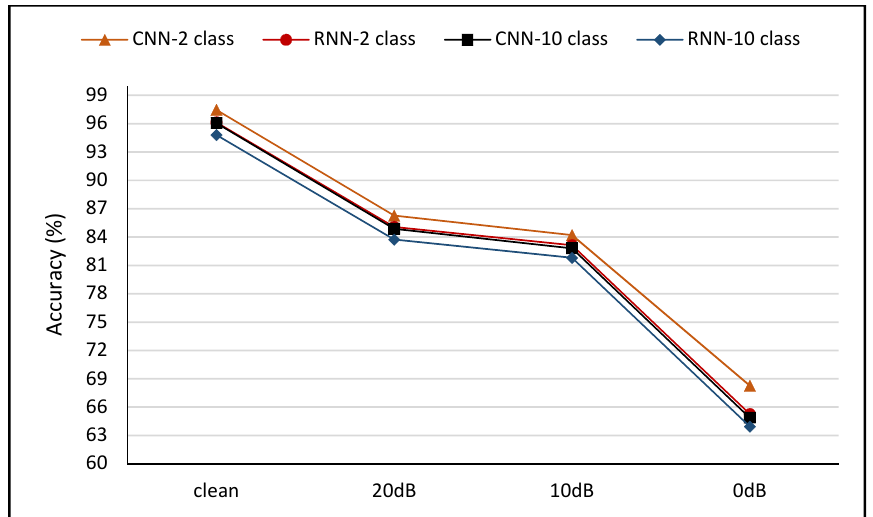
Figure 3. Impact of noisy data with non-augmented dataset.